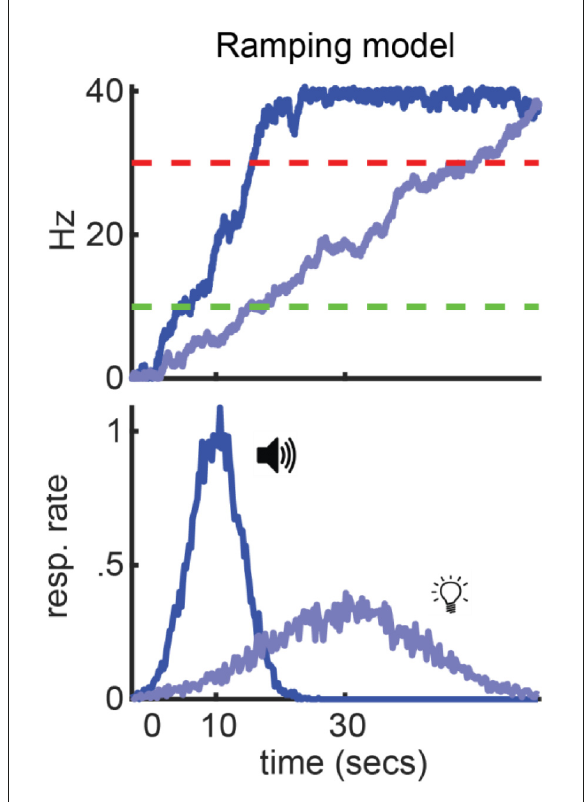
FIGURE2 Ramping model. Summary of how a ramping model would apply to a peak procedure where a tone and light signal reward after 10 and 30 s, respectively. Top: Simulated ramps for each cue (blue) and start/stop thresholds (green and red, respectively). Bottom: Simulated, idyllic